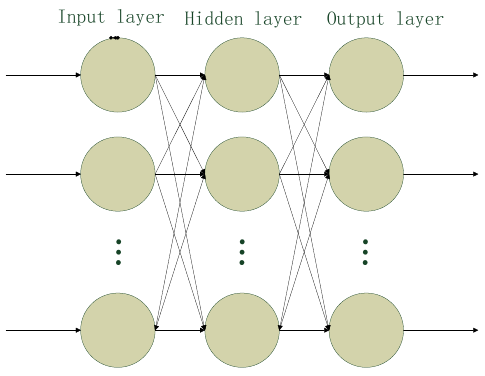
Figure 1. The framework of the extreme learning machine.